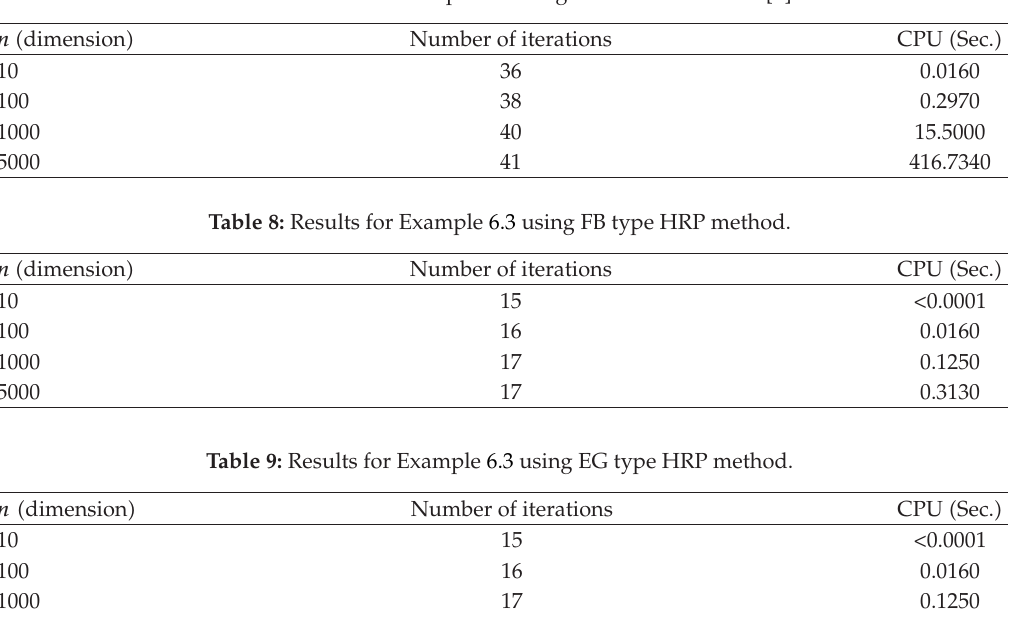
Table 7: Results for Example 6.3 using the HRP method in (cid:5) 2 (cid:6) .